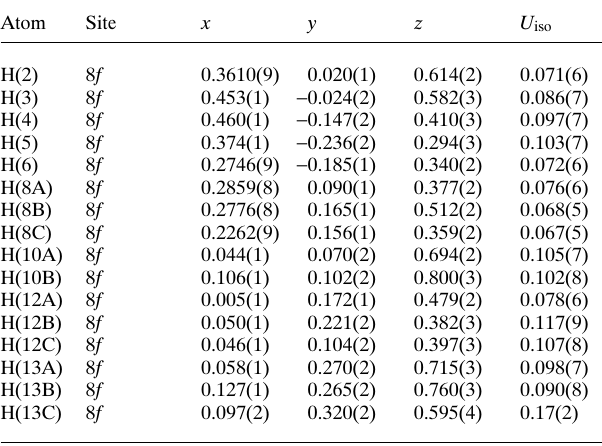
Table 2. Atomic coordinates and displacement parameters (in Å 2 )